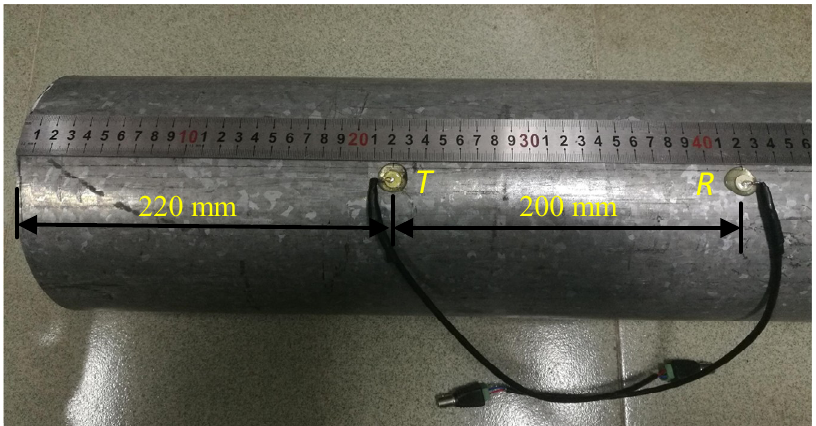
Figure 4. Lined anti-corrosion pipes with Lead Zirconate Titanate Transducer (PZT). T and R stands for excitation transducer and receiving transducer respectively.